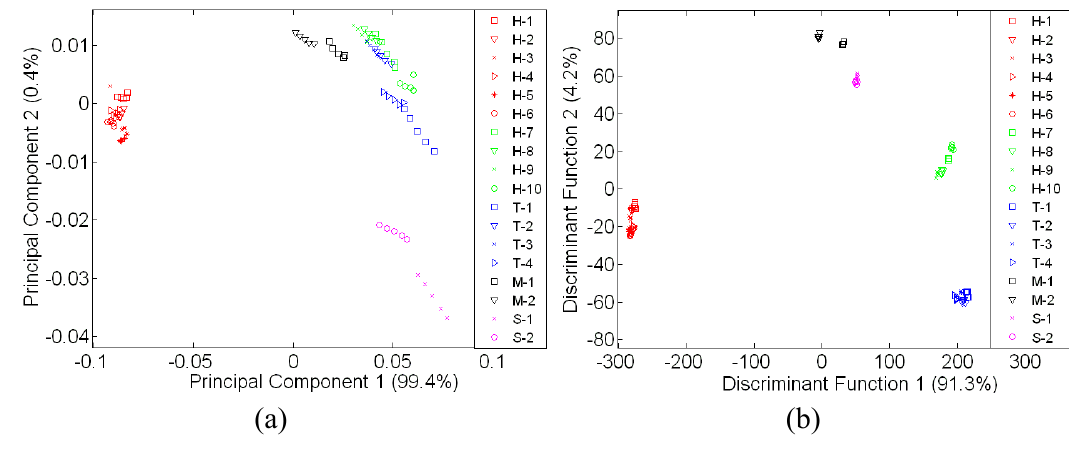
Figure 7. A global map of e-nose assessment on of 18 different honey, sugar and adulterated sample ( a ) Using PCA and ( b ) Using LDA.